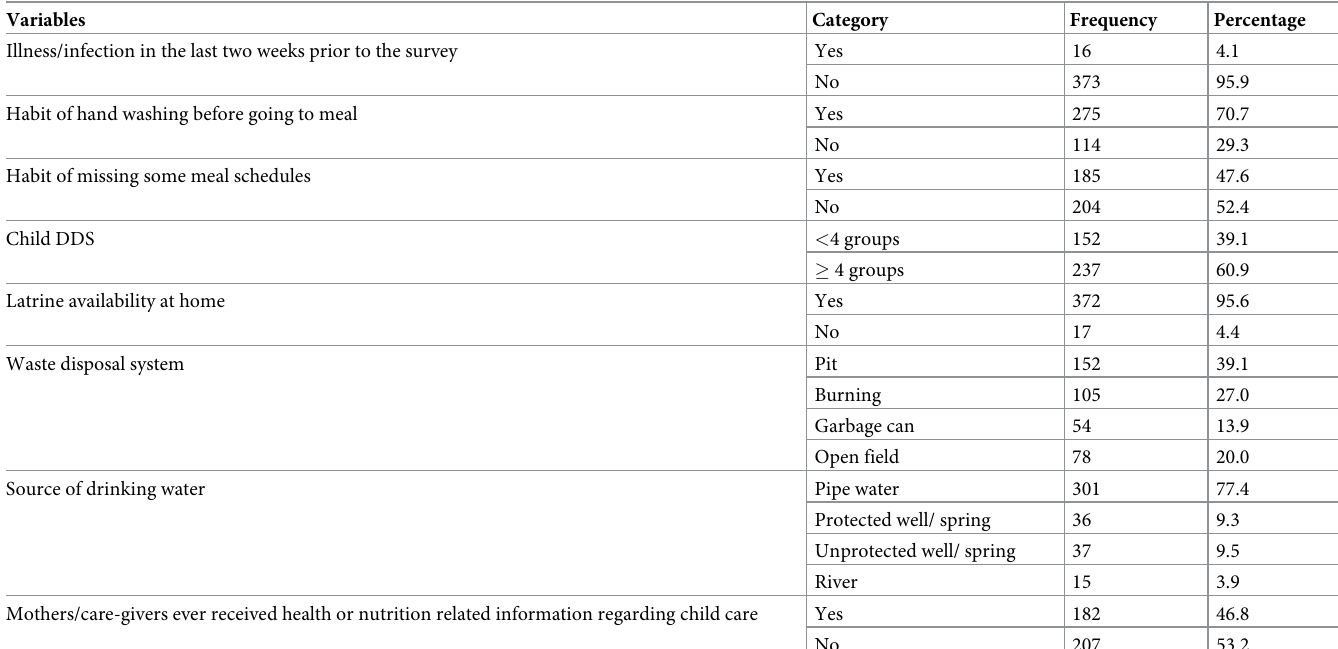
Table 2. Child health, dieting habit and environmental characteristics of study participants (n = 389), Arba Minch HDSS, Southern Ethiopia, April to May 2017.